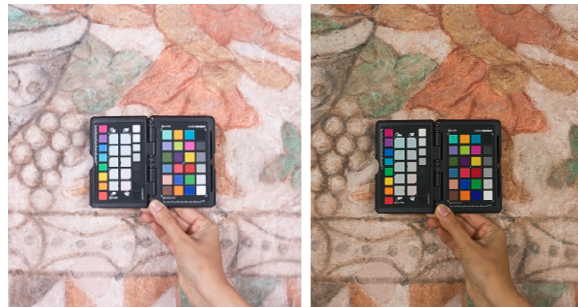
Figure 12 . Correcting Color with ColorChecker in the north wall of the nave. Images by CIMS © GCI 2019.